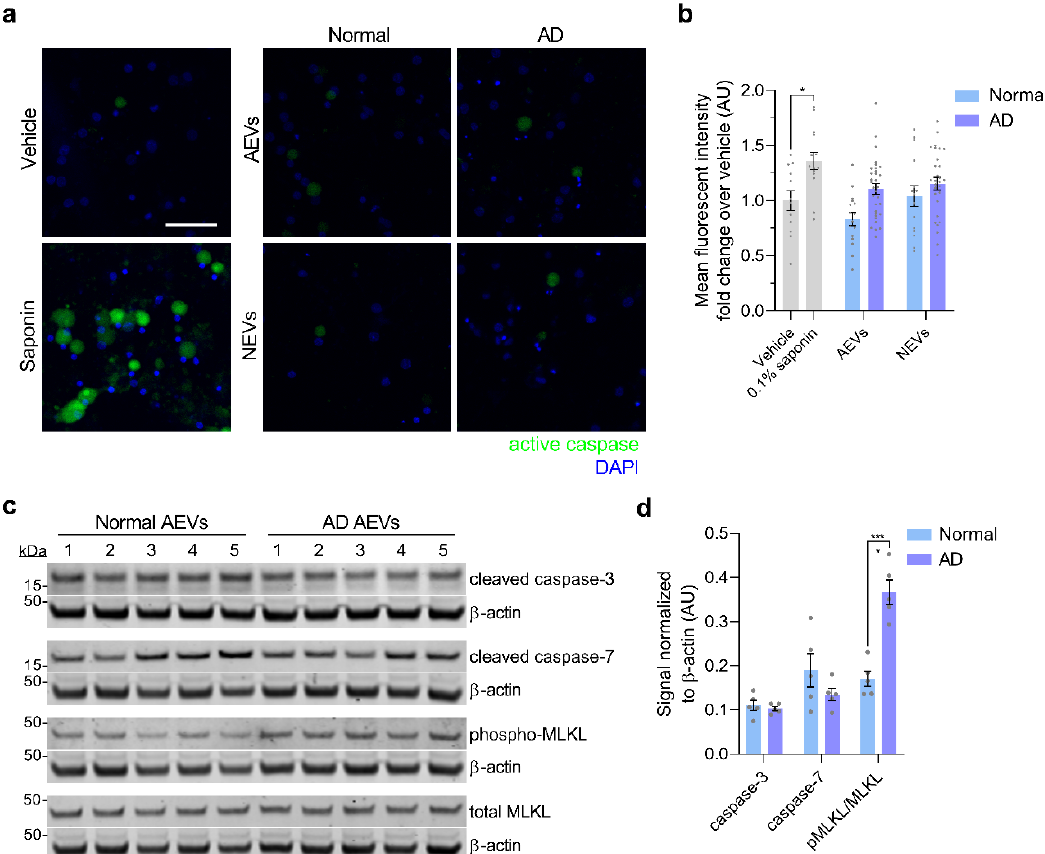
Figure 4. Neuronal activation of necroptosis, but not apoptosis, by AD AEVs. ( a ) Neurons treated with AD AEVs were subjected to an in vivo fluorescent caspase activity assay that allows the